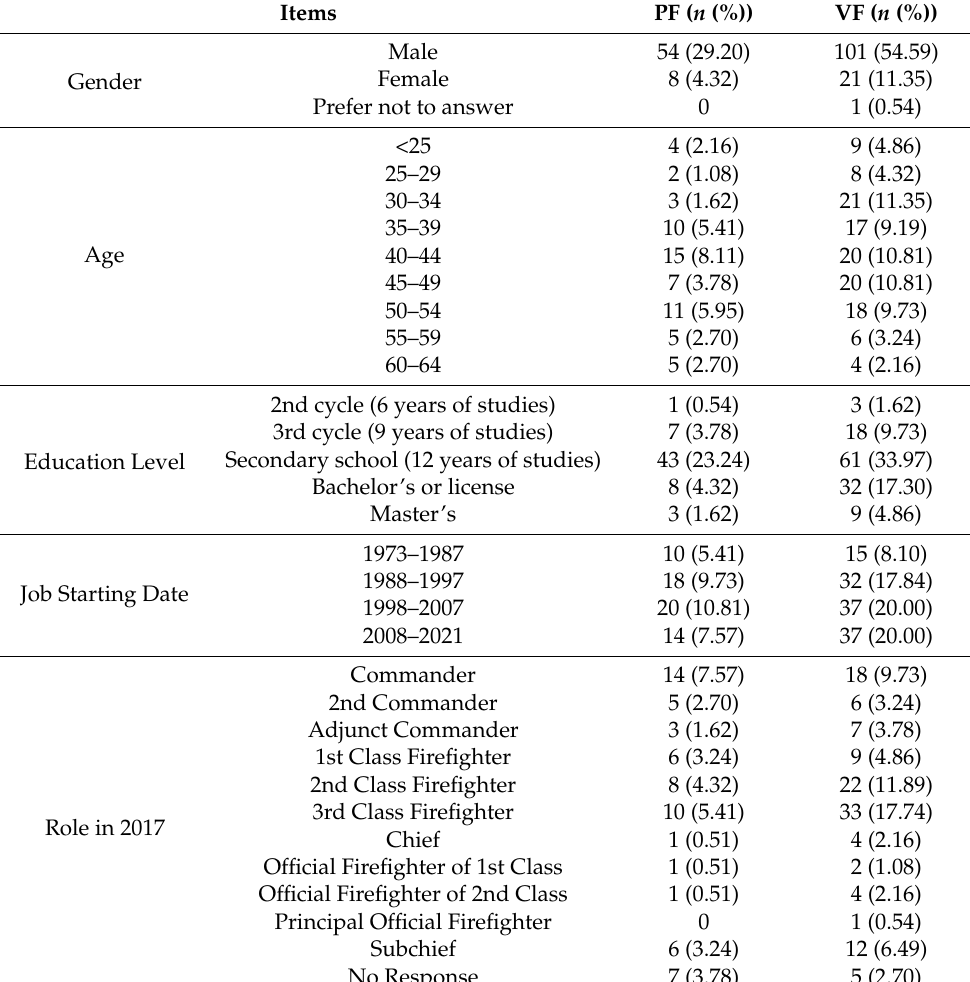
Table 1. Descriptive statistics considered for the